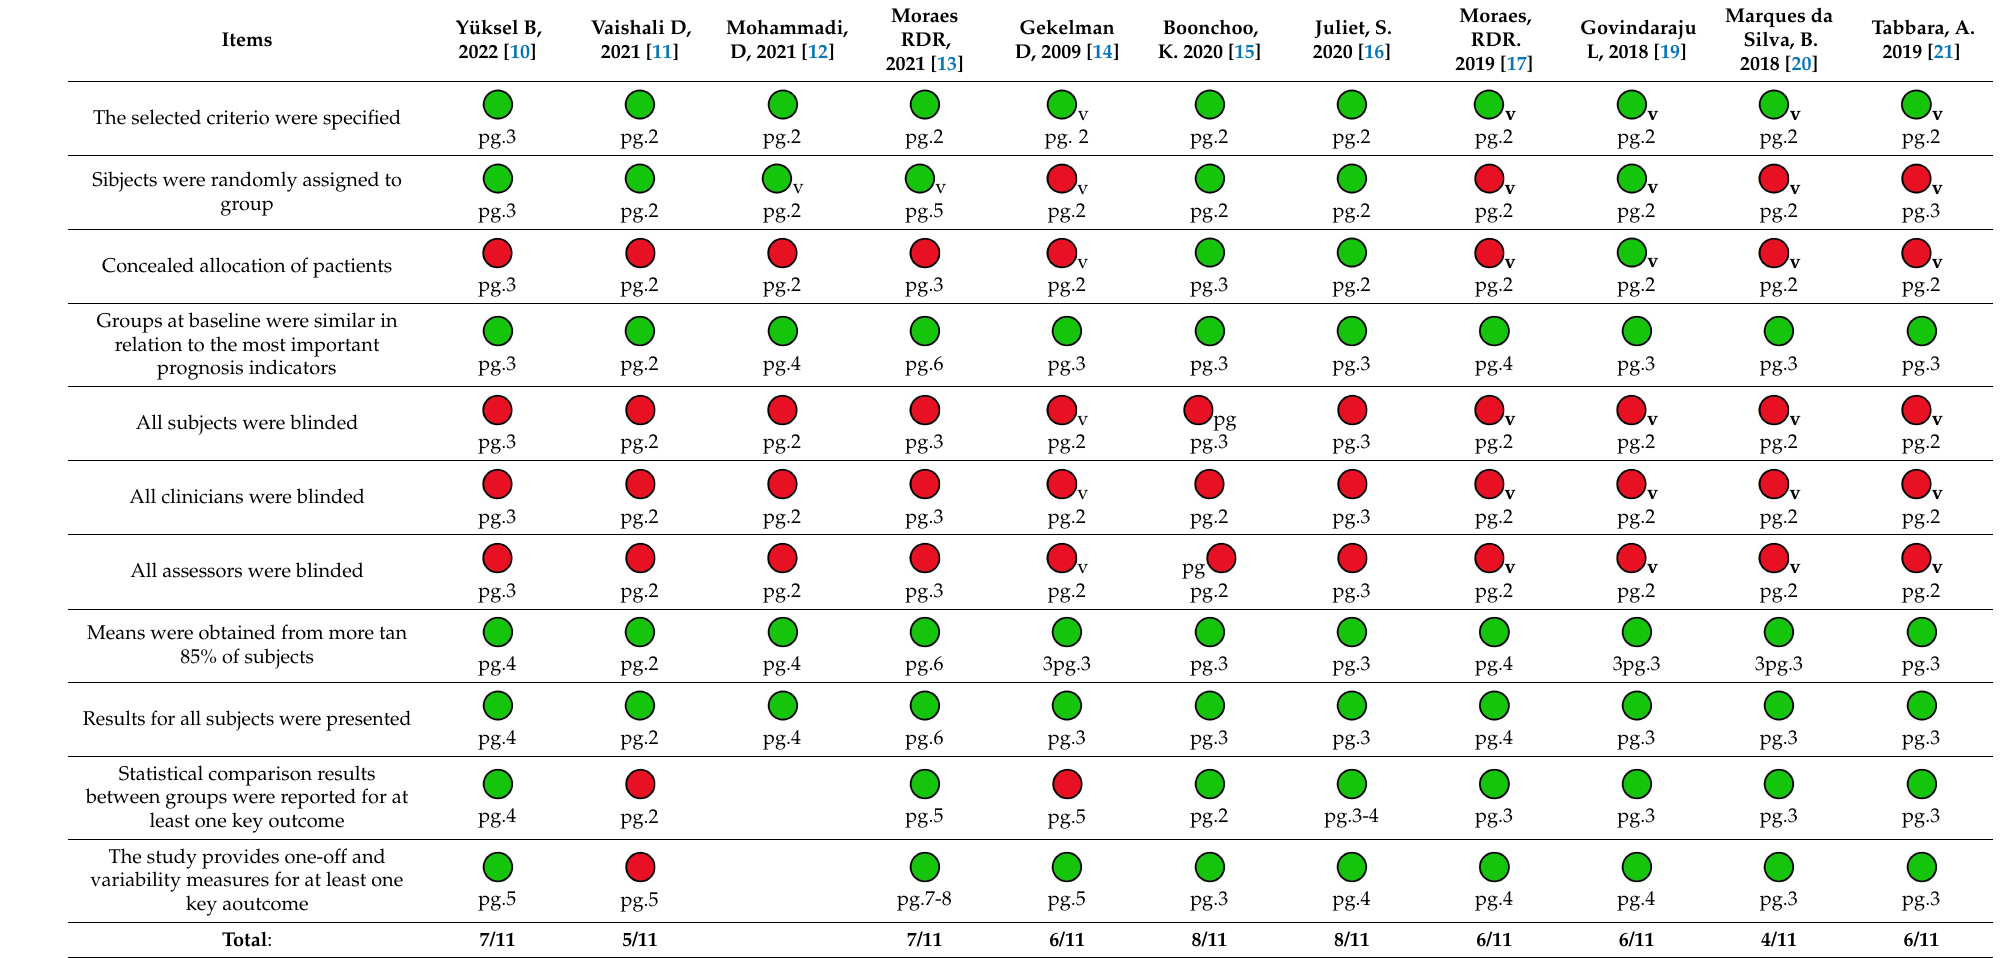
Table 2. Analysis of the articles according to the PEdro scale—experimental studies and